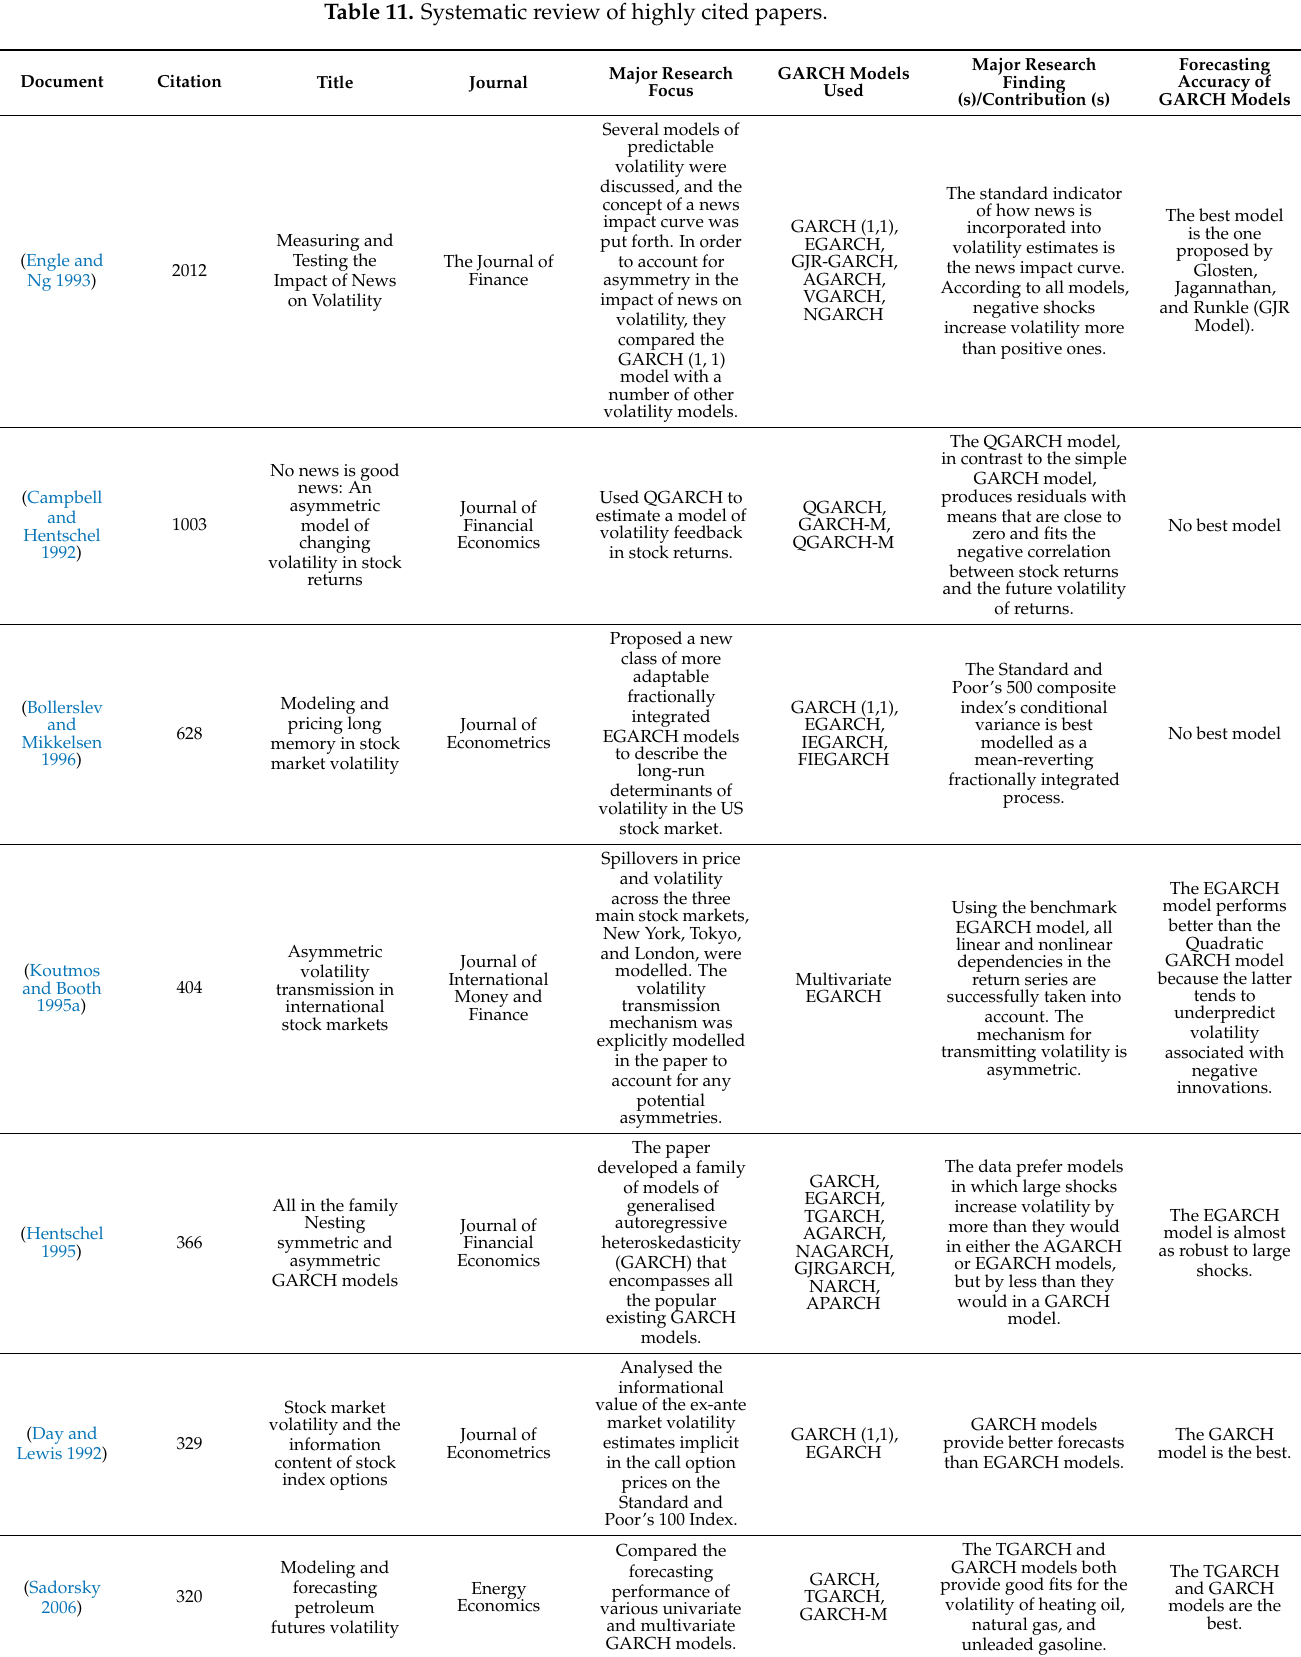
Table 11. Systematic review of highly cited